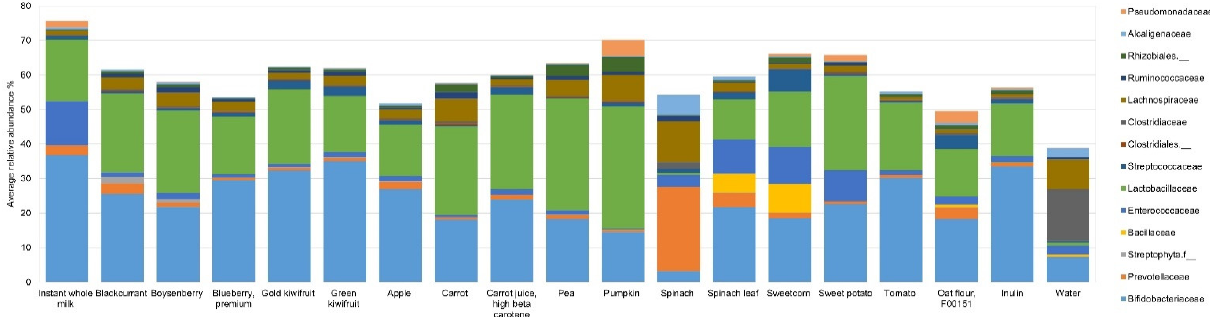
Figure 3. Average relative abundances (%) of bacterial families that differed significantly ( p < 0.005) with food ingredients, inulin (positive control), and water at 10 h of fermentation.